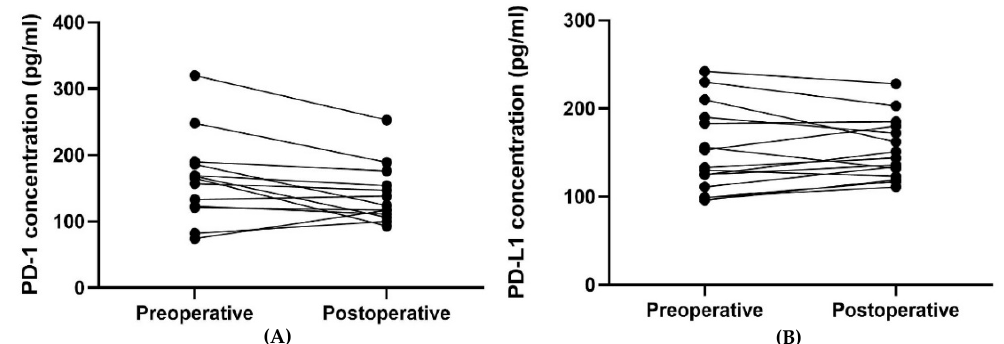
Figure 6. The plot visualizes the plasma concentrations of PD-1 ( A ) and PD-L1 ( B ) in the pre- (group 1A) and postoperative (group 1B) samples from patients undergoing radical surgery ( n = 15). In Figure 6A, one patient’s samples were removed since they were outliers (plasma concentration of PD-1 preoperative of 1105 pg/mL and postoperative 863 pg/mL) and made it difficult to visualize the other patients’ results.